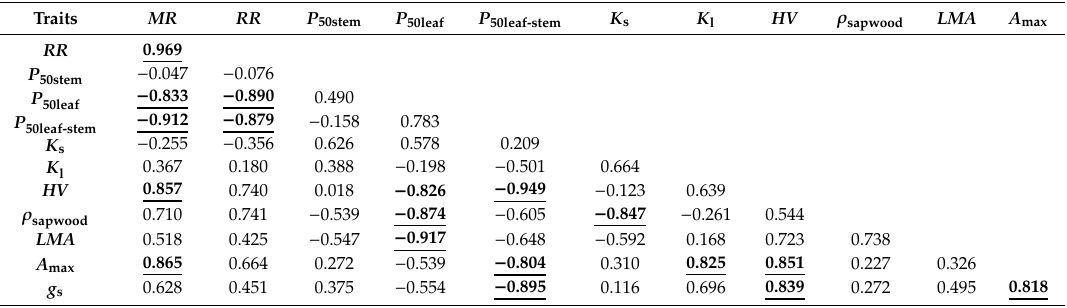
Table 3. Coe ffi cients of the Pearson’s correlations between mortality rate, recruitment rate, and hydraulic traits. The abbreviation of functional traits in Table 1. Significant relationships are shown in bold and underlined in the cross-species Pearson’s correlation ( P <